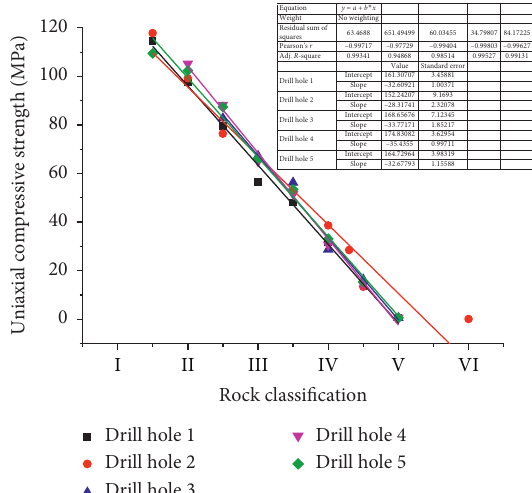
Figure 9: The relationship between uniaxial compressive strength and rock classification.